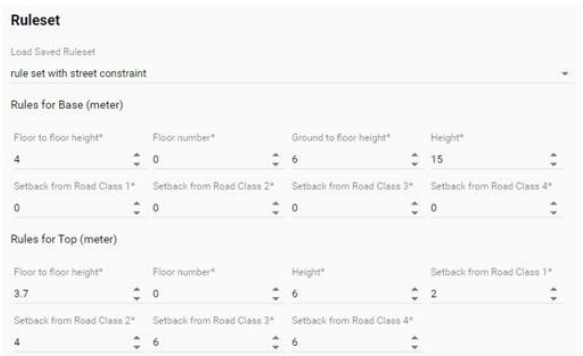
Figure 4. User-defined ruleset for both base and podium (top). Floor heights, floor numbers, setbacks are treated as rules at envelope level; setback rules can be applied at edge level and the height can be further applied at vertex level.